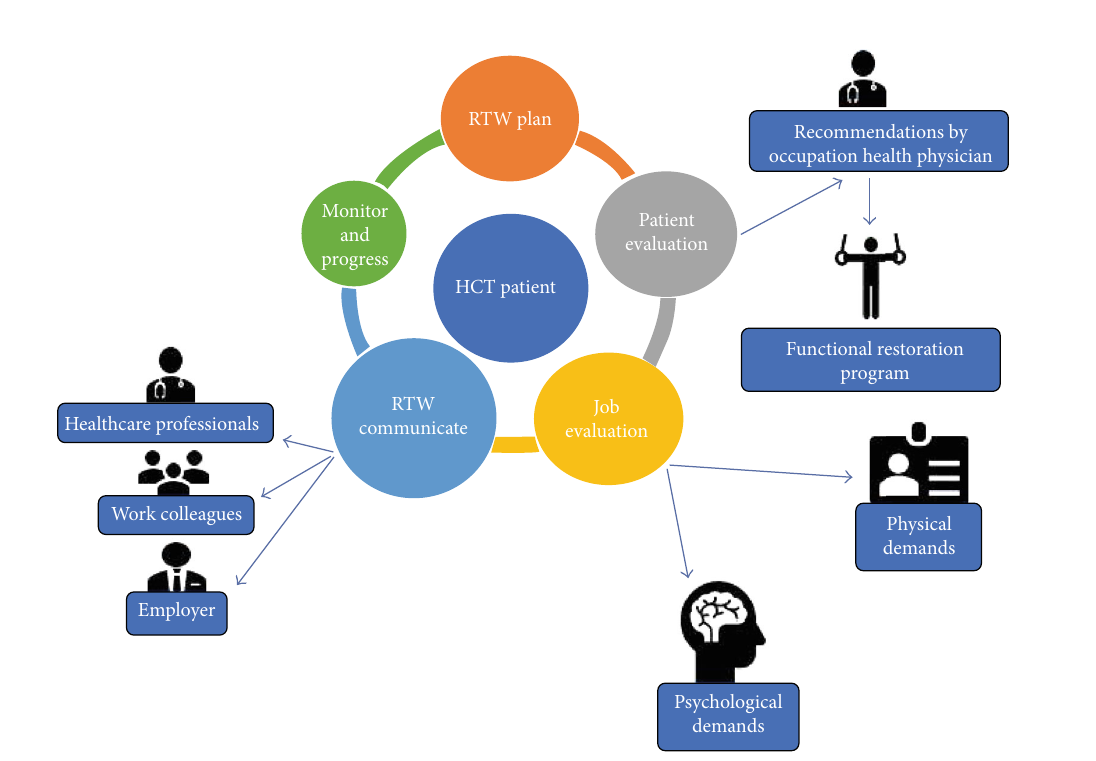
Figure 1: Recommended stages for return-to-work